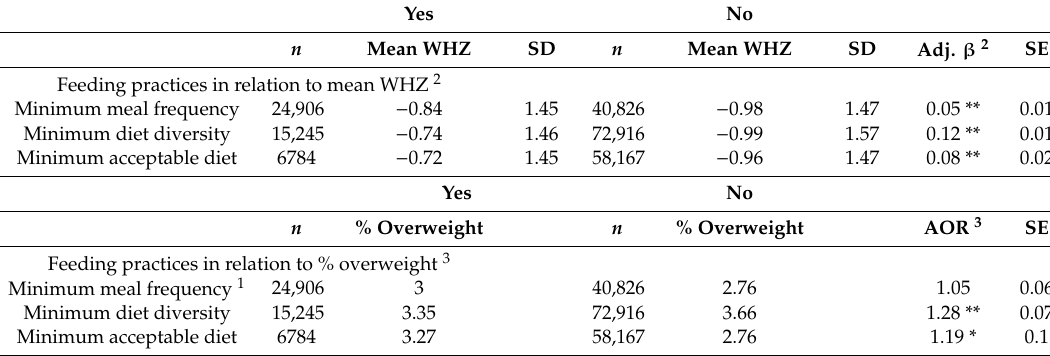
Table 3. Child weight-for-height z -score (WHZ) and prevalence of overweight 1 among children 6 to 23 months of age who met specific infant and young child feeding recommendations and those who did